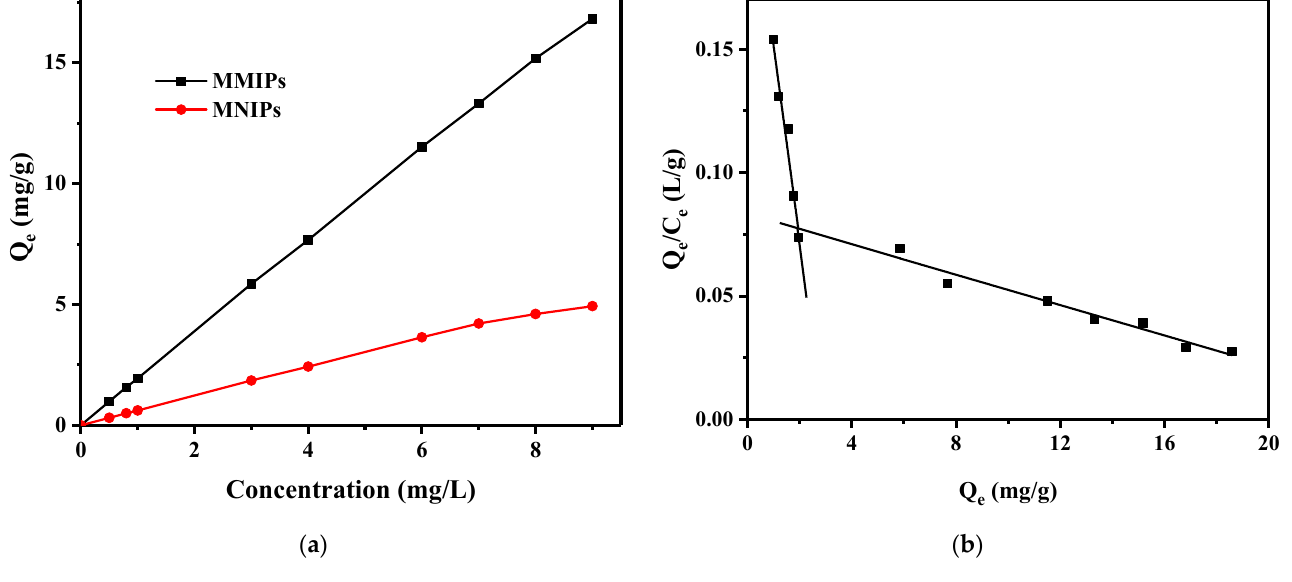
Figure 6. ( a ) Adsorption isotherms of MMIPs and MNIPs, and ( b ) Scatchard curve of MMIPs. Conditions: [E2] 0 = 5 mg/L, [MMIPs or MNIPs] 0 = 0.5 g/L, T = 30 °C, and pH = 6.0.